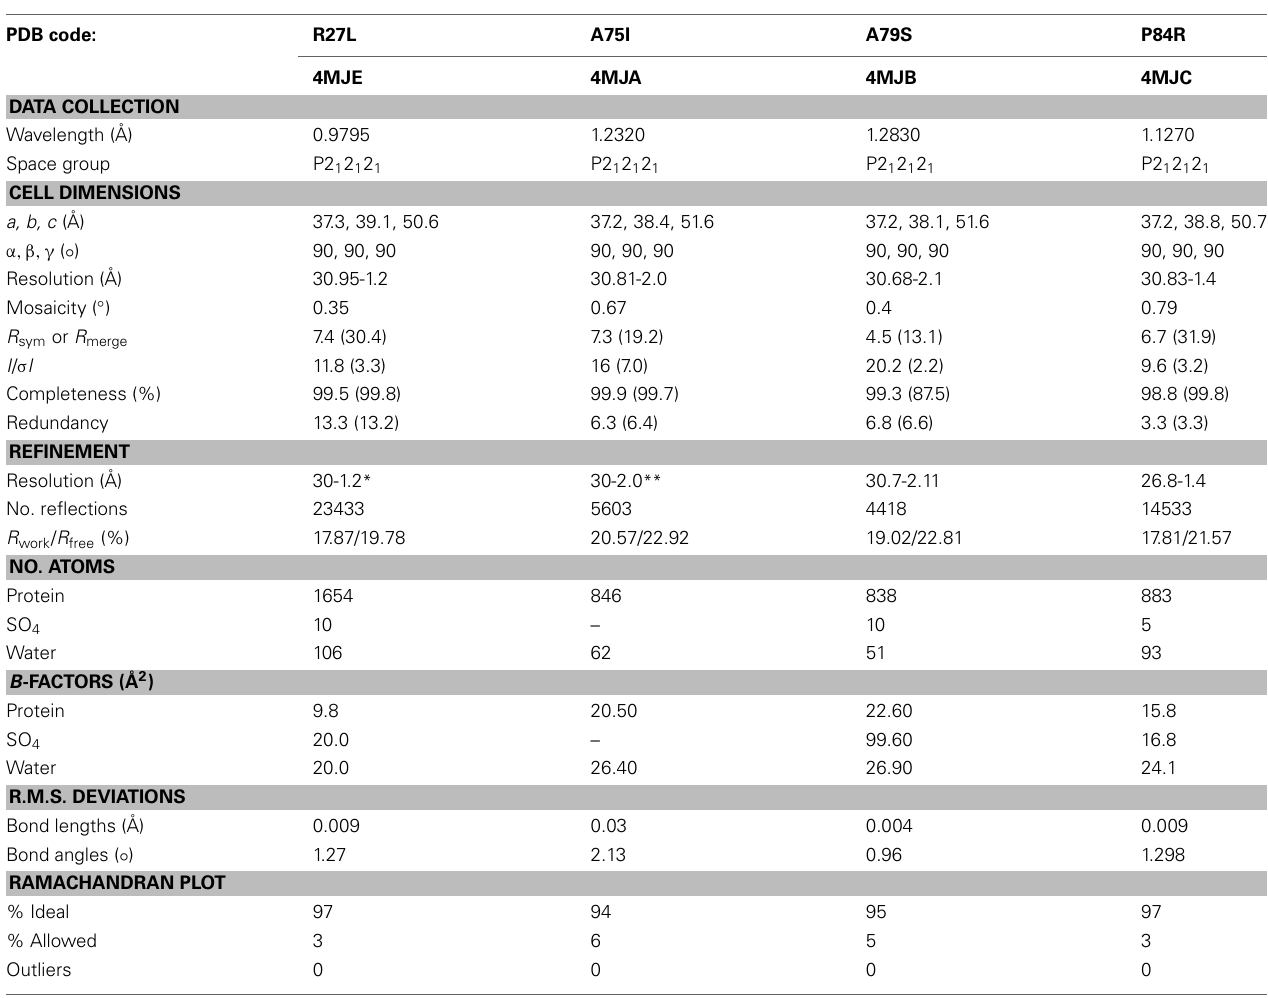
Table 2 | Data collection and refinement statistics.